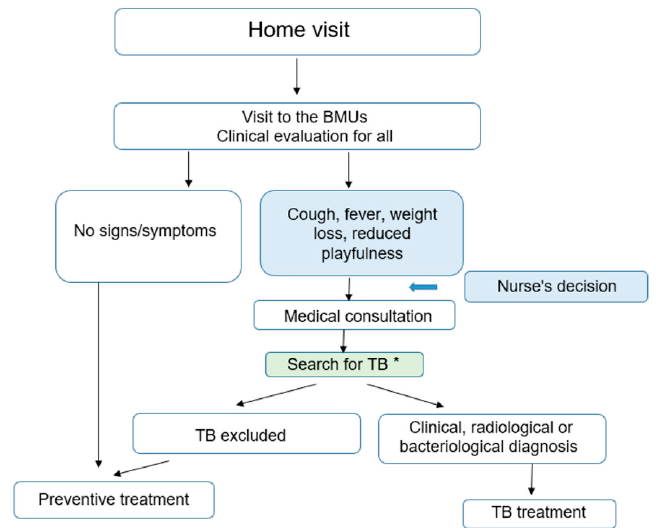
Figure 2. Screening algorithm used for children under 5 years. * the following additional